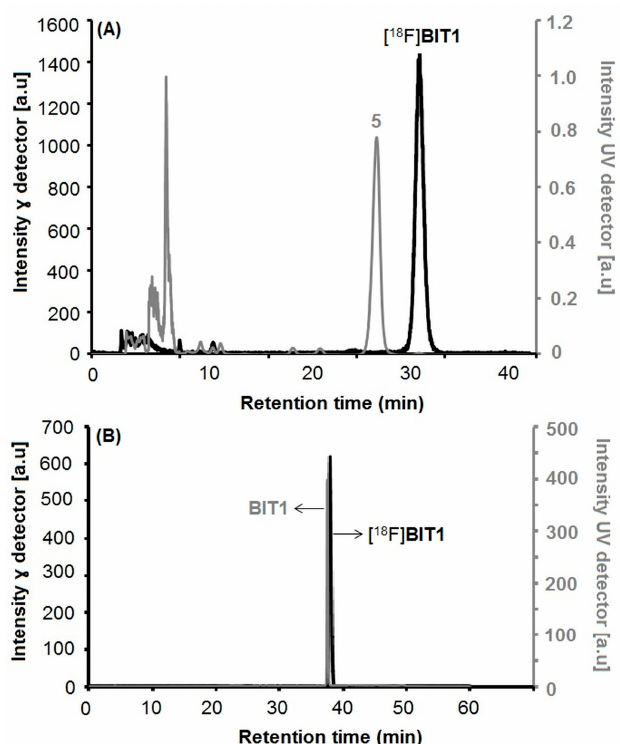
Figure 3. ( A ) Semi-preparative radio- and UV-HPLC chromatograms of [ 18 F] BIT1 (conditions: Reprosil-Pur C18-AQ, 250 × 10 mm, 46% MeCN / 20 mM NH 4 OAc aq ., 5.5 mL / min); ( B ) Analytical radio- and UV-HPLC chromatograms of the final product of [ 18 F] BIT1 spiked with the non-radioactive reference BIT1 (conditions: Reprosil-Pur C18-AQ, 250 × 4.6 mm, gradient system with eluent mixture of MeCN / 20 mM NH 4 OAc aq ., 1.0 mL / min).